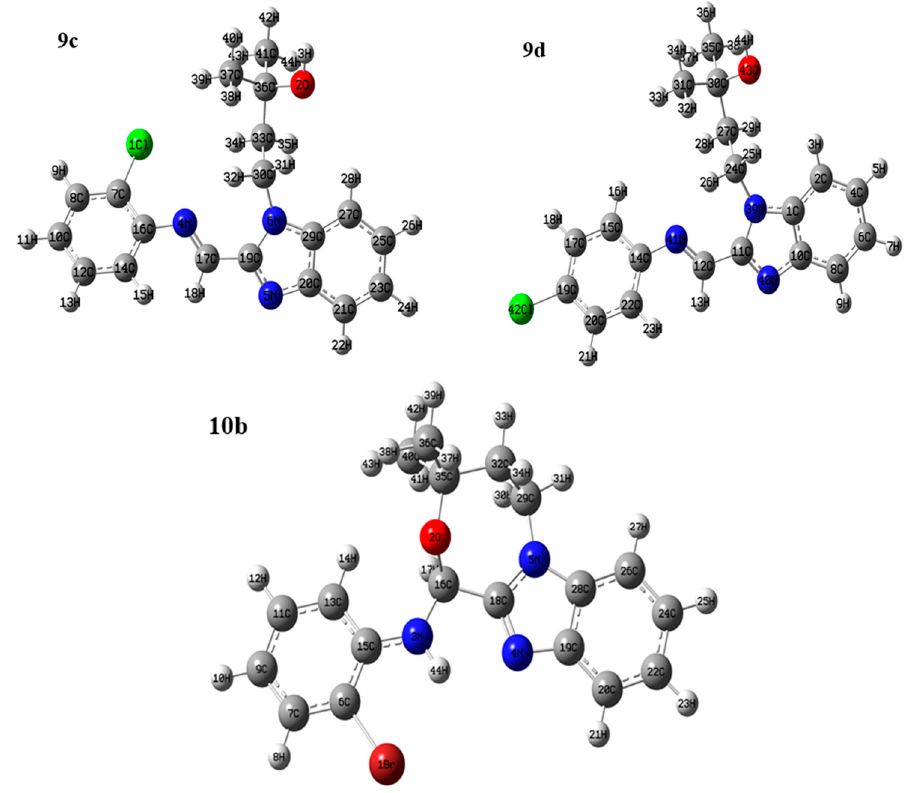
Figure 4. The optimized molecular structure of the studied compounds.